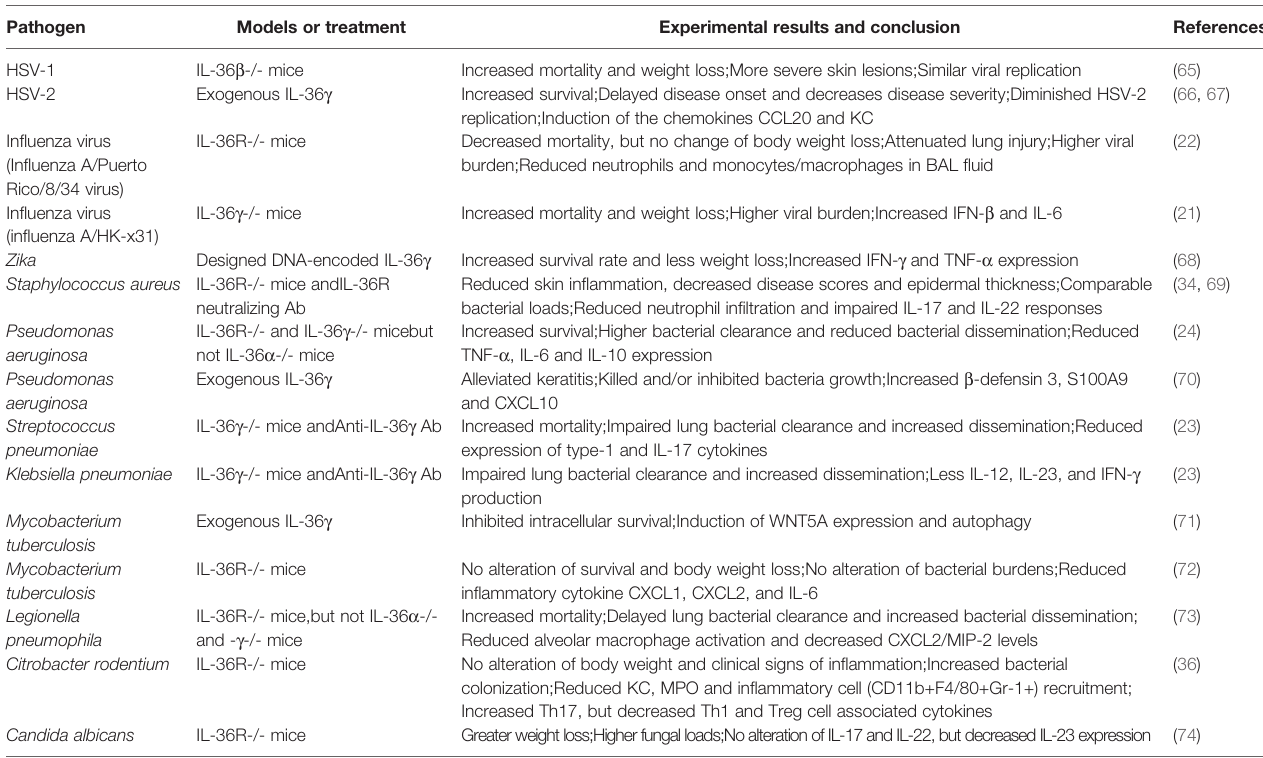
TABLE 1 | The functional role of IL-36 in infectious